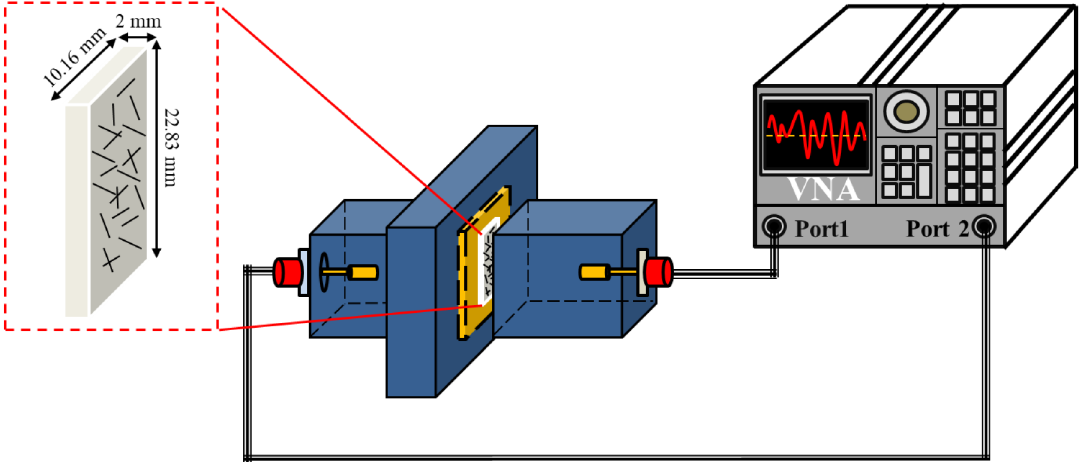
Fig. 3. Measurement setup for obtaining the scattering parameters of the microwire composite sample. The waveguide system includes two coaxial adapters (Port 1 and 2) connected to a vector network analyzer (frequency range: 8.2 – 12.4GHz). The size of the sample measured in the waveguide was 22.86 (cid:1) 10.16 (cid:1) 2 mm 3